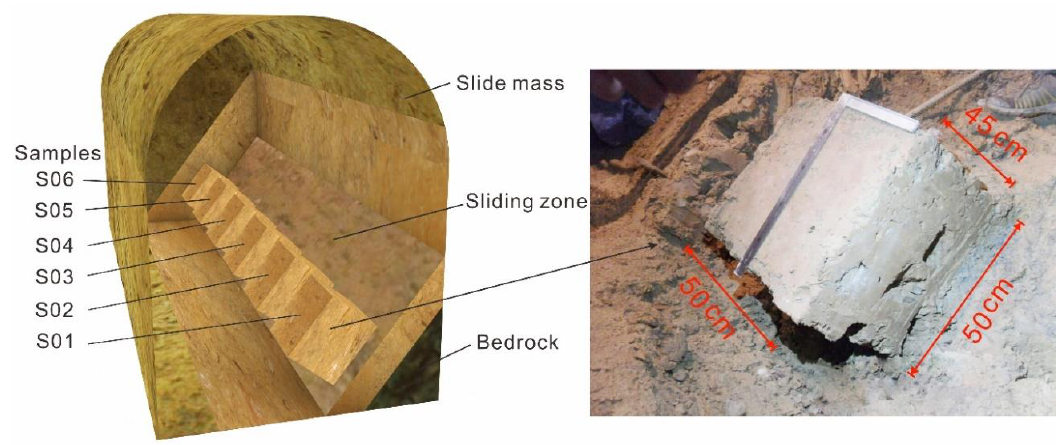
Figure 5. Prepared samples for the in situ shear test in the No.3 testing tunnel in the Huangtupo